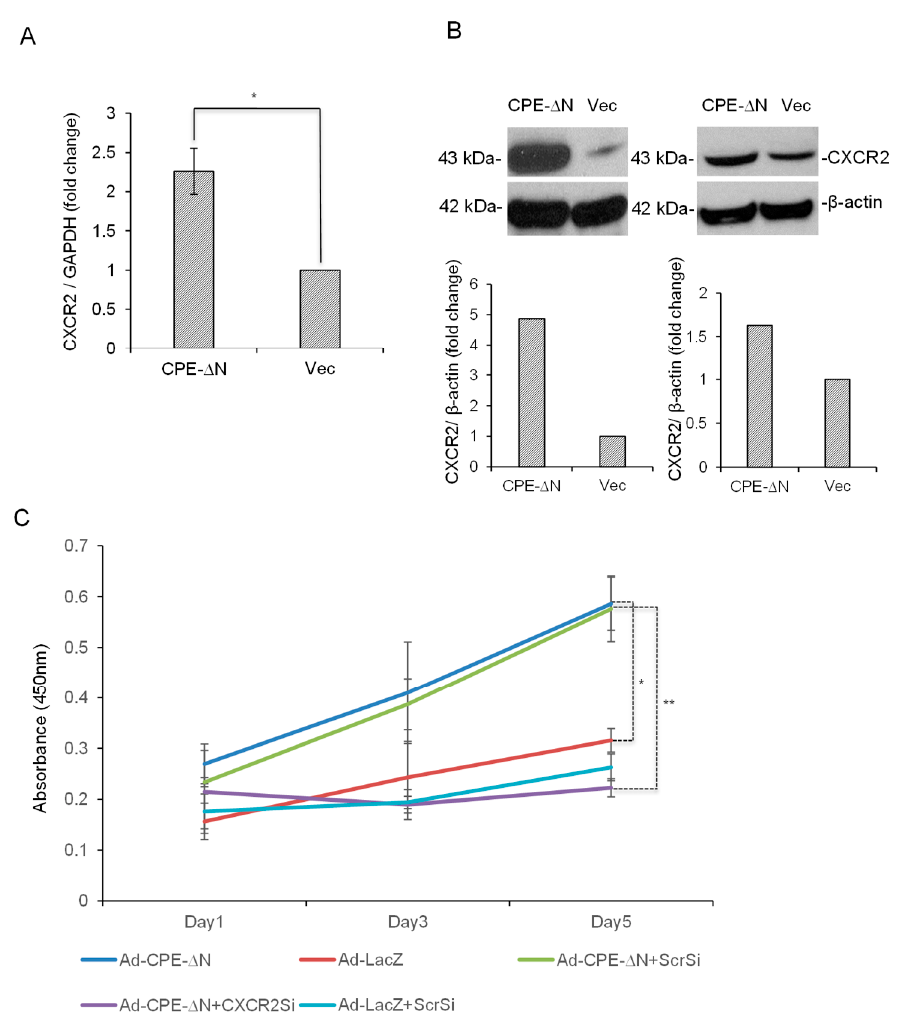
Figure 4. CPE- ∆ N upregulates CXCR2 expression and promotes the proliferation of Panc-1 cells in a CXCR2-dependent manner. ( A ) Bar graph showing the increase in expression of CXCR2 mRNA in Panc-1 cells transfected with 2 µ g of CPE- ∆ N plasmid compared to control cells. GAPDH (glyceraldehyde 3-phosphate dehydrogenase) was used as the reference gene for qRT-PCR analysis. ( N = 2, n = 3, * p < 0.05). Error bars denote SEM. ( B ) Western blot images (upper panel) and the corresponding quantitative analysis (lower panel) showing an increase in expression of CXCR2 protein in Panc-1 cells transfected with 3 µ g of CPE- ∆ N compared to vector-transfected cells. β -actin was used as the loading control for Western blot. Full-length blots are presented in Supplementary Figure S3. ( C ) Line graph of MTT assay showing the proliferation of Panc-1 cells transduced with adenovirus carrying CPE- ∆ N for 48 h followed by transfection (for 48 h) with CXCR2 siRNA on day 1, day 3 and day 5. Adenovirus encoding LacZ and scrambled siRNA were used as controls for CPE- ∆ N overexpression and transfection, respectively. ( N = 1, n = 3, * p < 0.05, ** p < 0.01). Error bars denote SD.